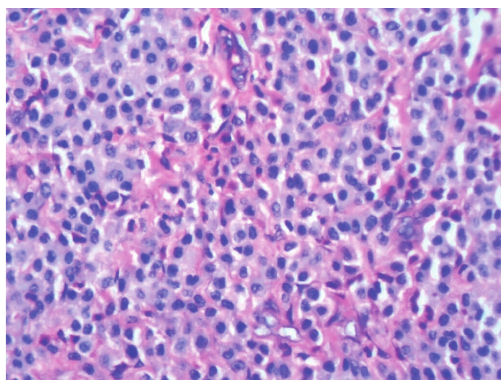
Figure 4: CD 117 IHC. Membrane staining of mast